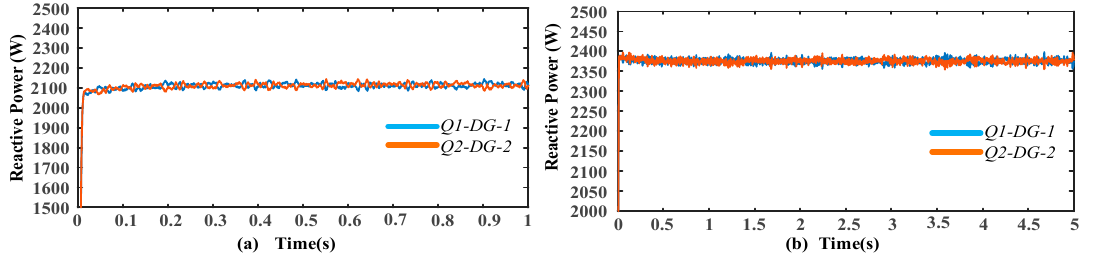
Figure 8. ( a ) Reactive power for the conventional control strategy; ( b ) reactive power for proposed control strategy.